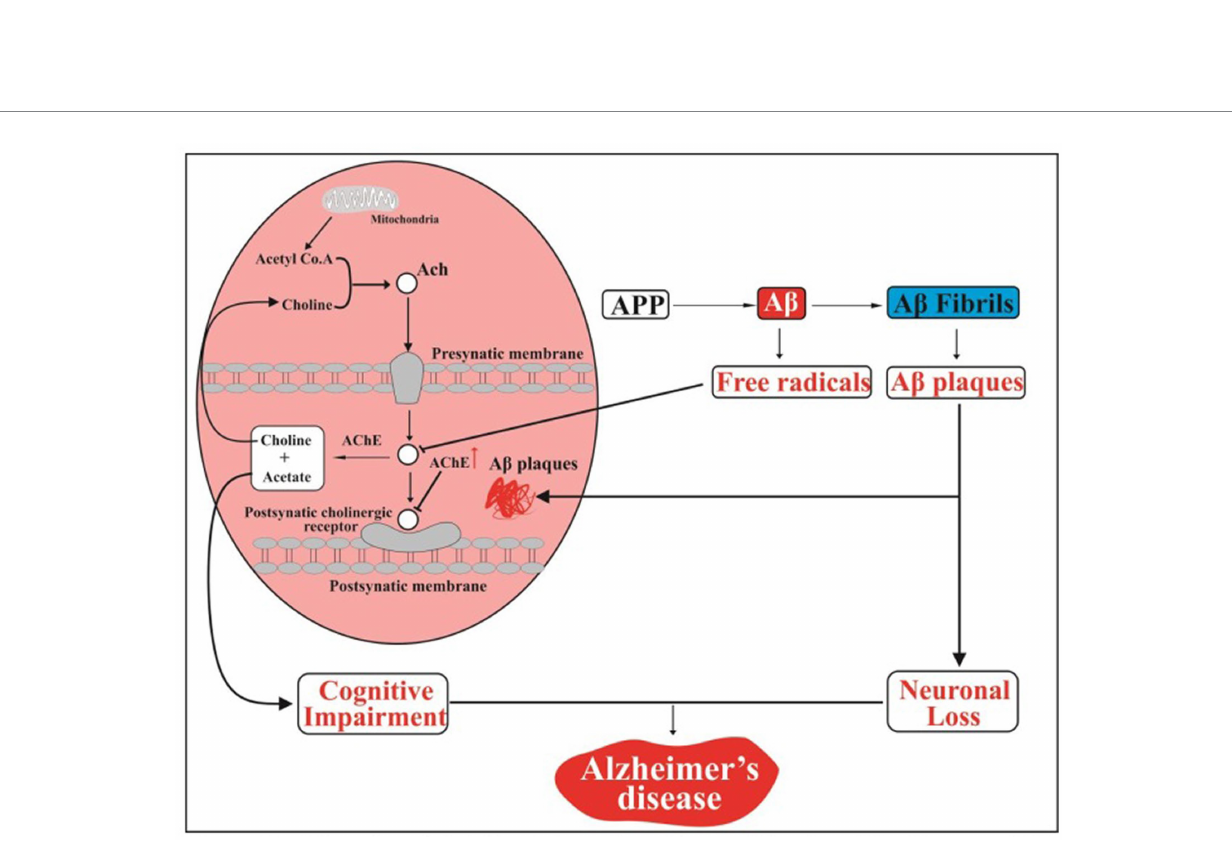
FIGURE 7 A β and acetylcholine interactions in an AD schematic diagram. APP, Amyloid precursor protein; A β , Amyloid-beta; Ach, acetylcholine; AChE, acetylcholinesterase (DeTure and Dickson, 2019). Created with